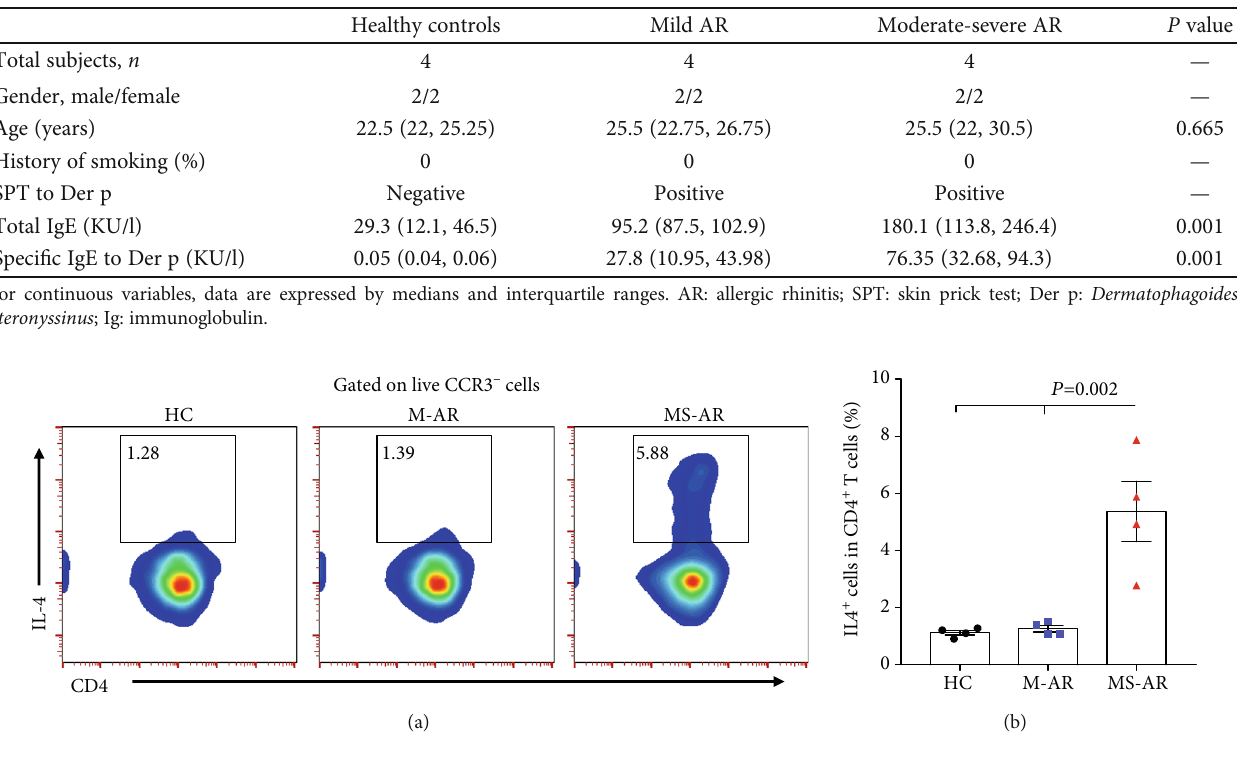
Figure 6: Blood eosinophils derived from moderate-severe allergic rhinitis have a pro-Th2 capacity. (a) Representative fl ow plots and (b) quanti fi cation of IL-4 expression by CD4 + T cells obtained from healthy controls after coculture with blood eosinophils from healthy controls, mild allergic rhinitis, and moderate-severe allergic rhinitis for fi ve days. HC: healthy controls; M-AR: mild allergic rhinitis; MS- AR: moderate-severe allergic